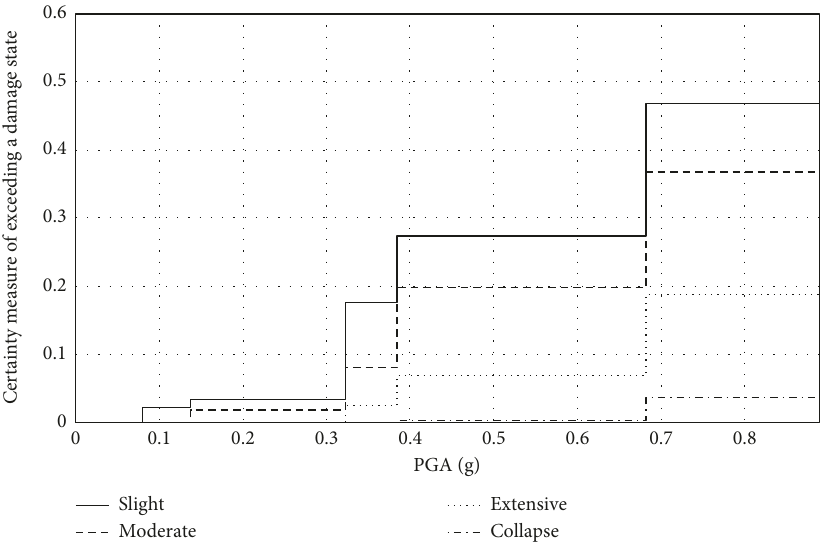
Figure 6: Empirical fragility curves of damage state subsets determined by measuring certainty of possibility distributions for PGA (g) intervals.